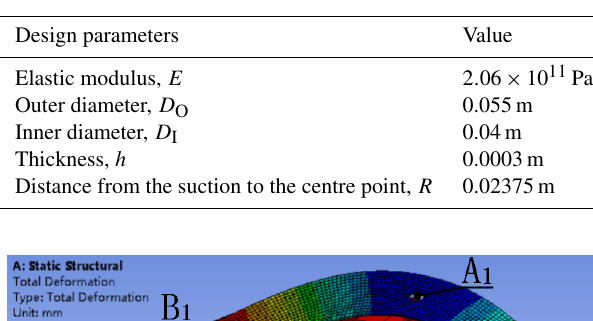
Table 1. Design parameters of leaf spring.